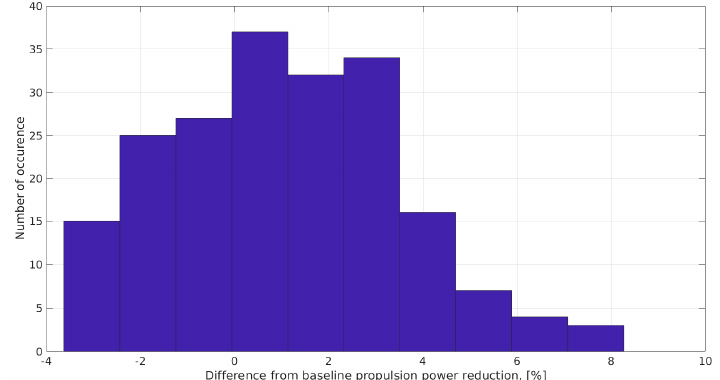
Figure 11. Results of the variation study for the one-rotor ship.